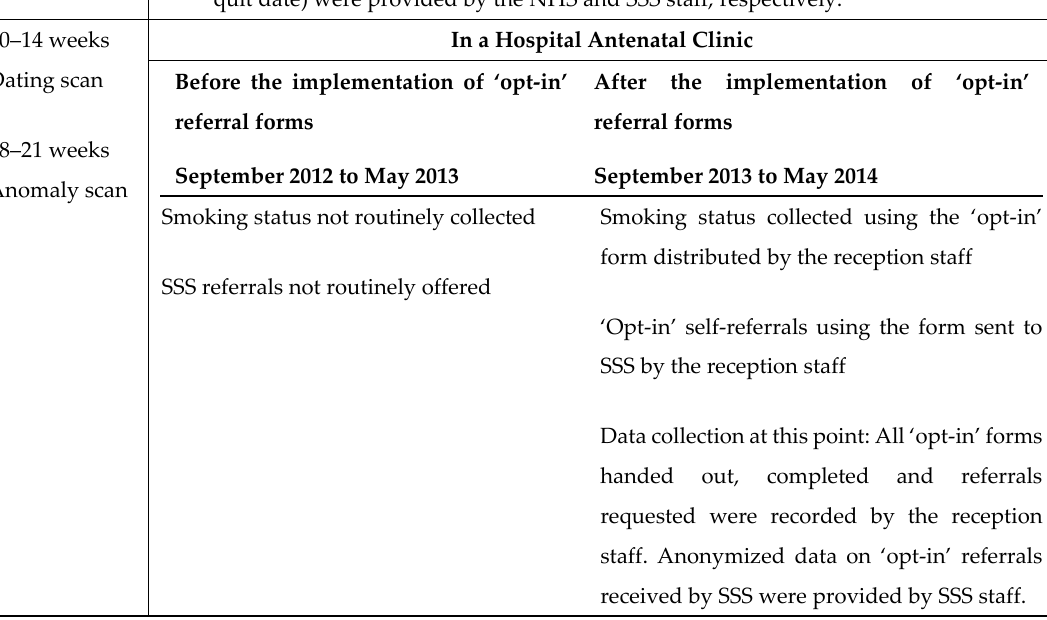
Figure 1. Smoking cessation practices and study data collection at key antenatal appointments in the periods before and after implementation of the ‘opt-in’ referral forms.